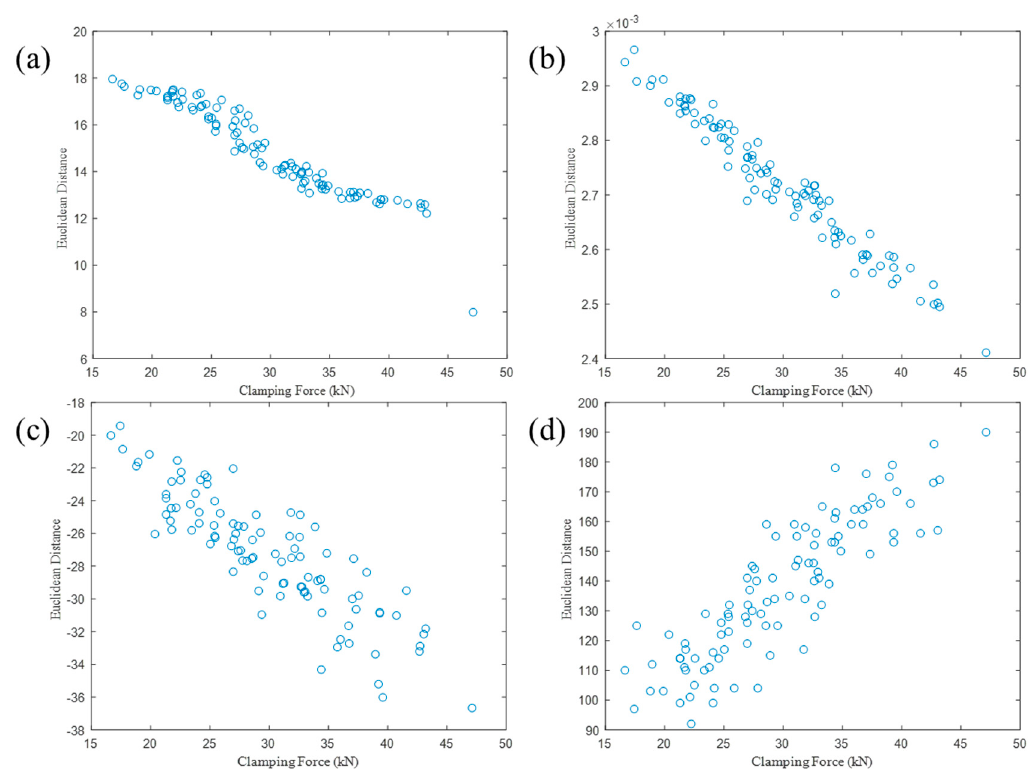
Figure 3. Comparison of Euclidean distance for determination of bolt clamping force by vibration responses calculated by different by machine learning algorithms: ( a ) k-means, ( b ) principal component analysis (PCA), ( c ) agglomerative clustering, ( d ) density-based spatial clustering of application with noise (DBSCAN).